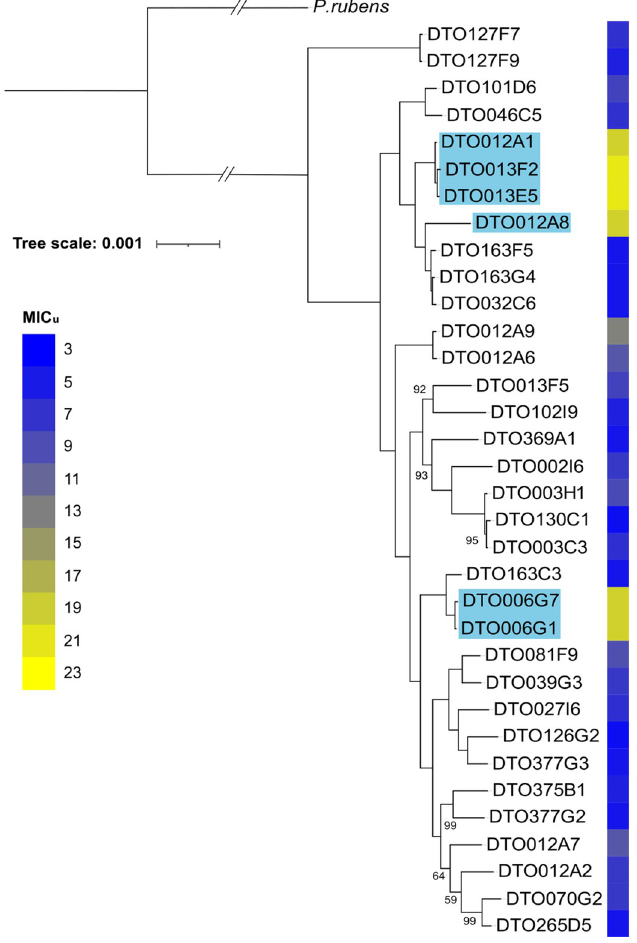
Fig 3. Phylogeny of the P . roqueforti strains. Phylogenetic tree of the 34 P . roqueforti strains used in this study. Sorbic acid resistance (MIC u ) is indicated in blue-yellow shading. The tree is based on 6923 single-copy orthologous genes and was constructed using RAxML. P . rubens [44] was used as outgroup. Bootstrap values < 100 are indicated. Strains containing the SORBUS cluster are highlighted in